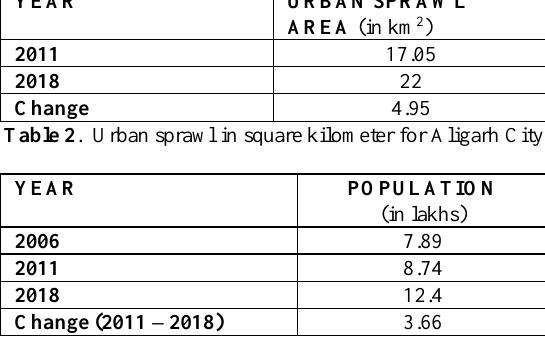
Table 3 . Population census data for